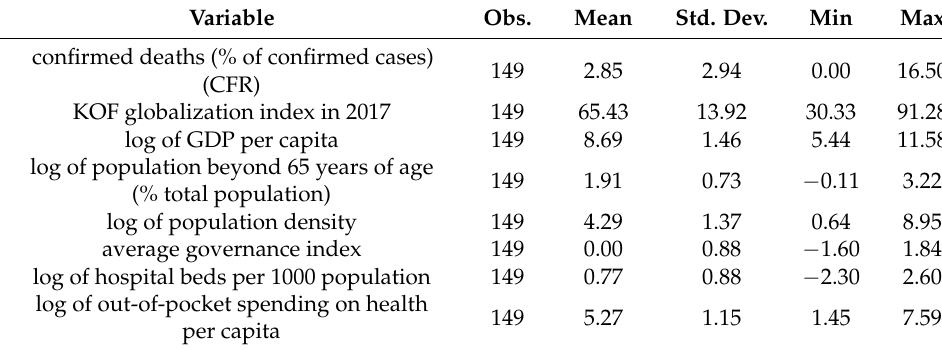
Table 1. Summary